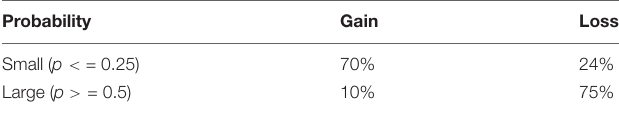
TABLE 2 | Percentage of Risk Seeking choices for outcome probabilities in gain and loss conditions.